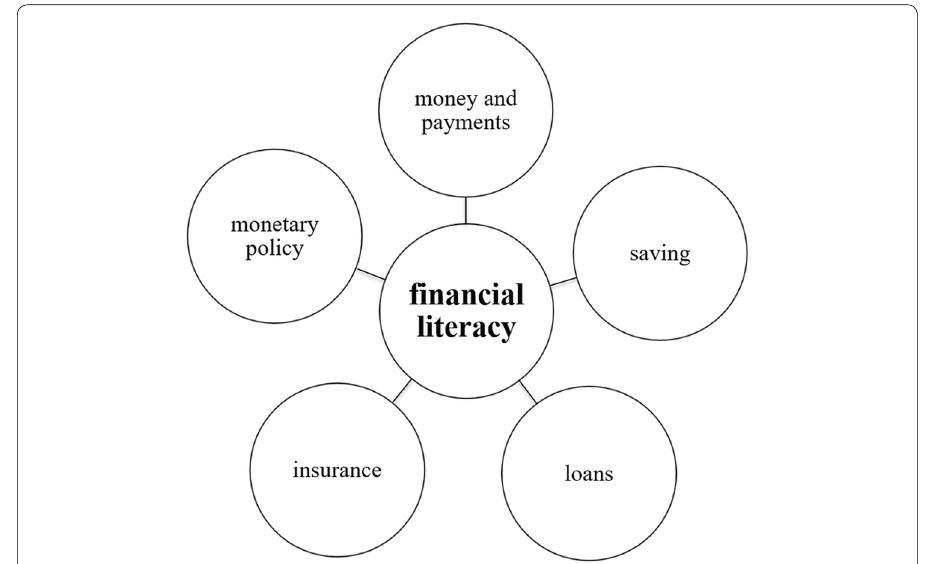
Fig. 2 Content facets of financial literacy (Rudeloff